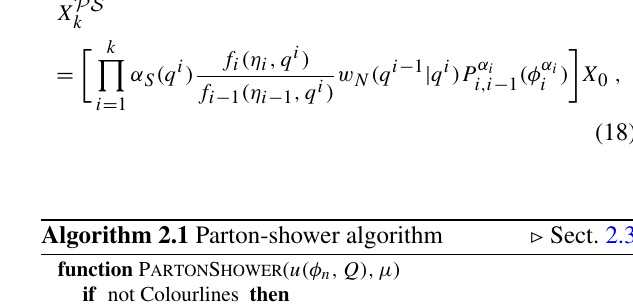
Algorithm 2.1 Parton-shower